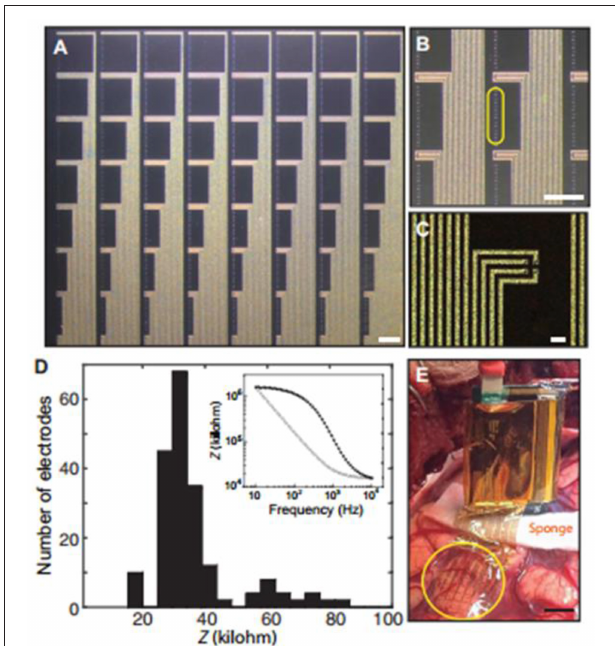
FIGURE 9 | Device structure and characterization of NeuroGrid for intraoperative recording. (A) Photo of NeuroGrid (240 channel, scale bar, 1mm). (B) Amplified picture of electrodes arranged in 2 × 2 tetrodes (2mm spacing between each tetrode, scale bar, 1mm). (C) Structure of electrodes coated by conducting polymer involving a single tetrode (scale bar, 20mm). (D) Histogram displaying impedance of a single NeuroGrid: yield = 87.5% (240 electrodes involved). Inset: electrochemical impedance phase and magnitude of a single electrode at the level of physiological frequencies. (E) Photograph of intraoperation by putting NeuroGrid (240-channel, yellow circle, scale bar, 1cm) on the surface of the cortex (Khodagholy et al., 2016). Copyright © 2016 American Association for the Advancement of Science.